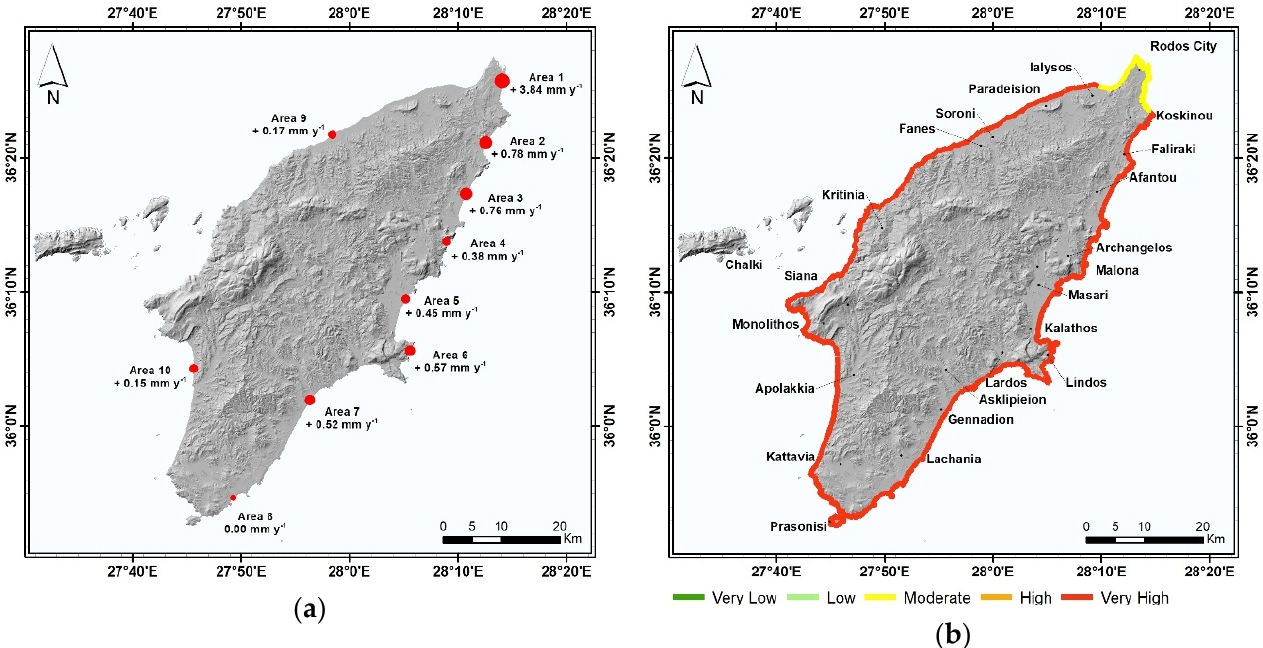
Figure 9. ( a ) Representative uplift rates along the Rhodes Island coastal zone (red bullets). ( b ) Evaluation of the relative coastal vulnerability due to mean vertical land movements for the present and the projected to 2100 conditions.